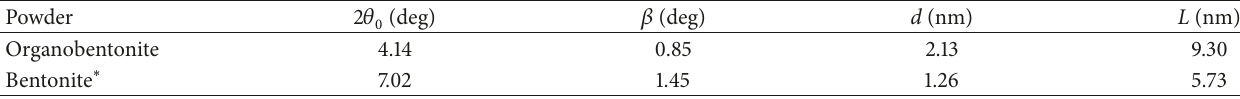
Table 3: Results of XRD analysis for bentonite and organobentonite powders.